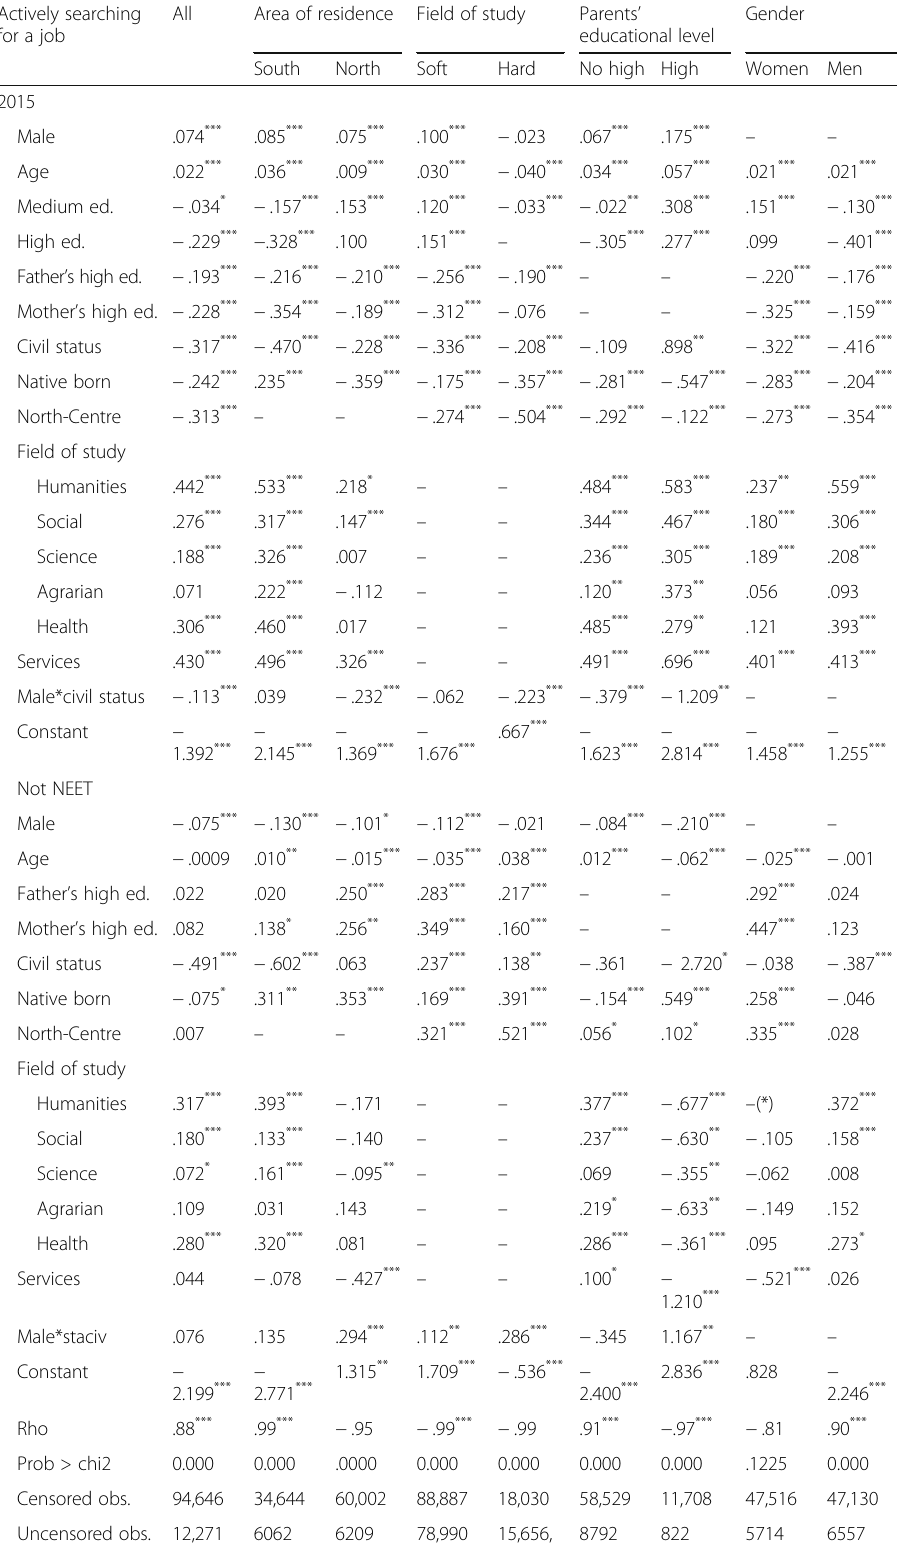
Table 4 Bivariate probit model for the probability of being not NEET and looking for a job Actively searching for a